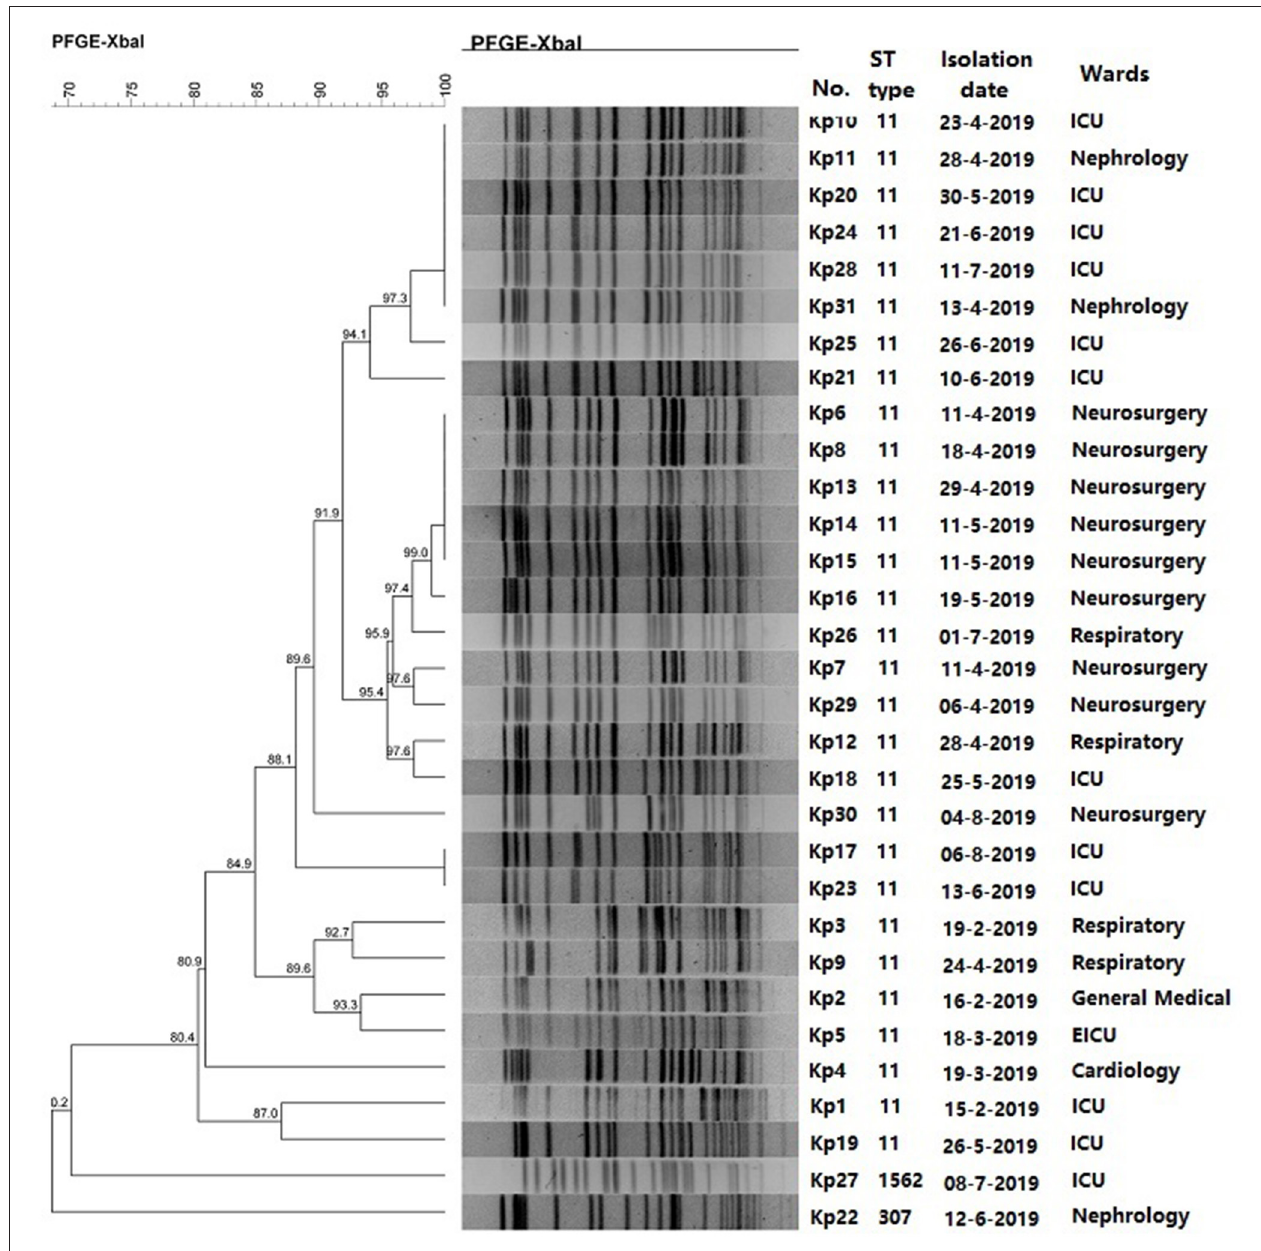
FIGURE 1 | PFGE results and MLST typing for 31 CRKp